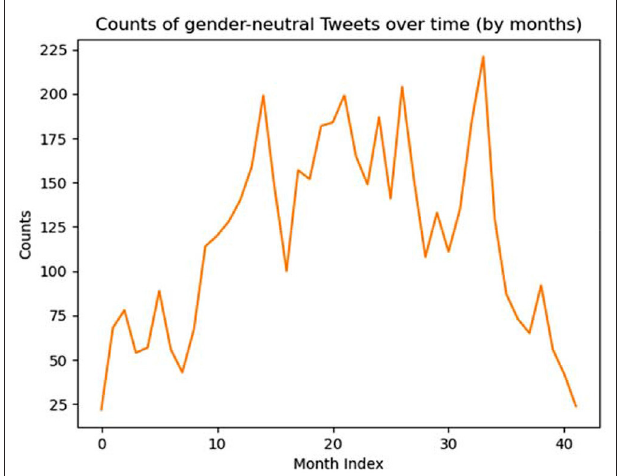
FIGURE 2 | Frequency of gender-neutral expressions by month in GBALP.